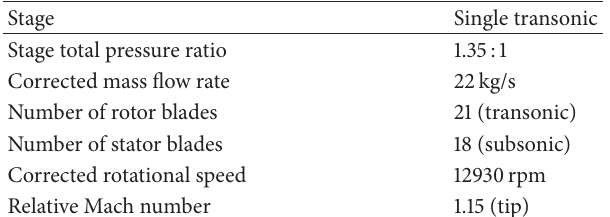
Table 1: Design specifications of the transonic compressor